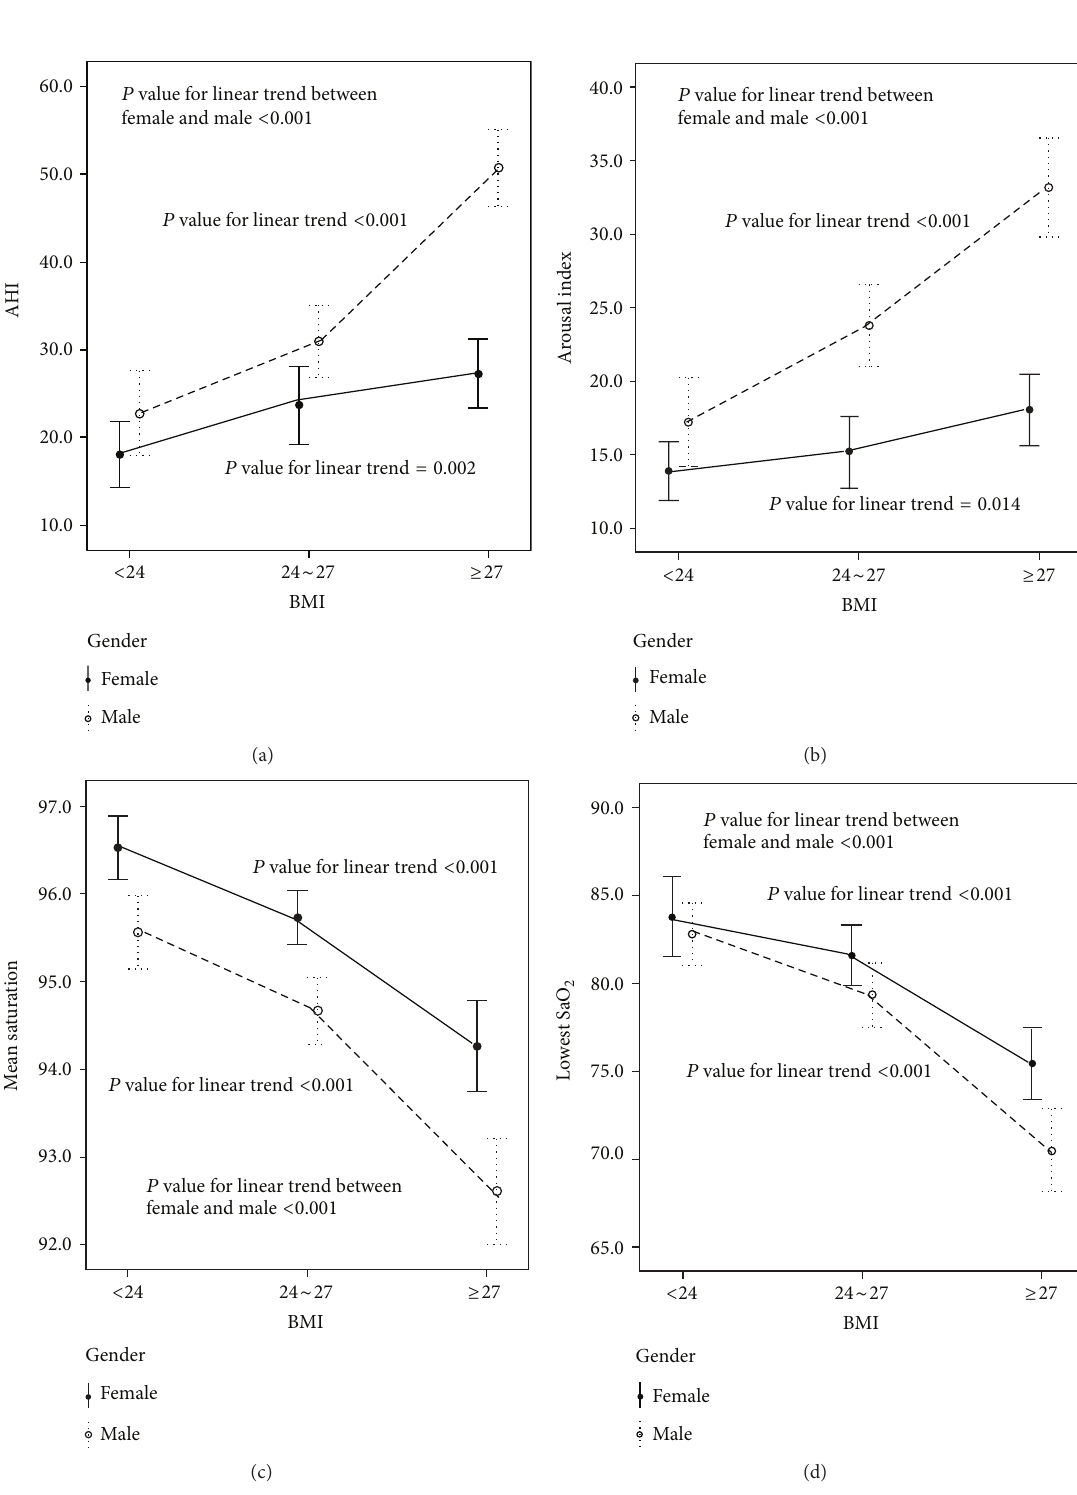
Figure 2: The trends of AHI, arousal index, mean saturation, and lowest saturation in both BMI- and age-matched male and female patients withOSA.AstheBMIincreased,theAHIandarousalindexincreasedsignificantly,whilethemeansaturationandlowestsaturationdecreased significantly in both genders. These trends were significantly predominant in the male